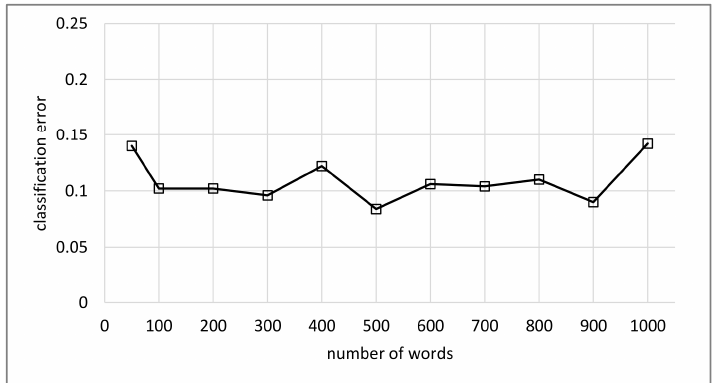
Figure 8. Comparison of different visual vocabulary sizes using SVM classifier for the ADon dataset.